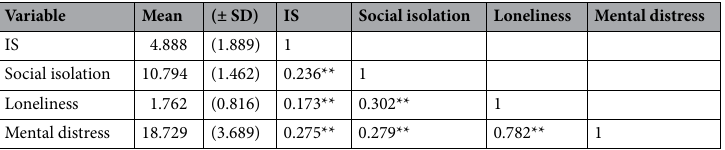
Table 2. Means, standard deviations, and zero-order Pearson’s correlations between core study variables with Bonferroni Correction for multiple comparisons. IS impaired sleep. ** p < 0.001.